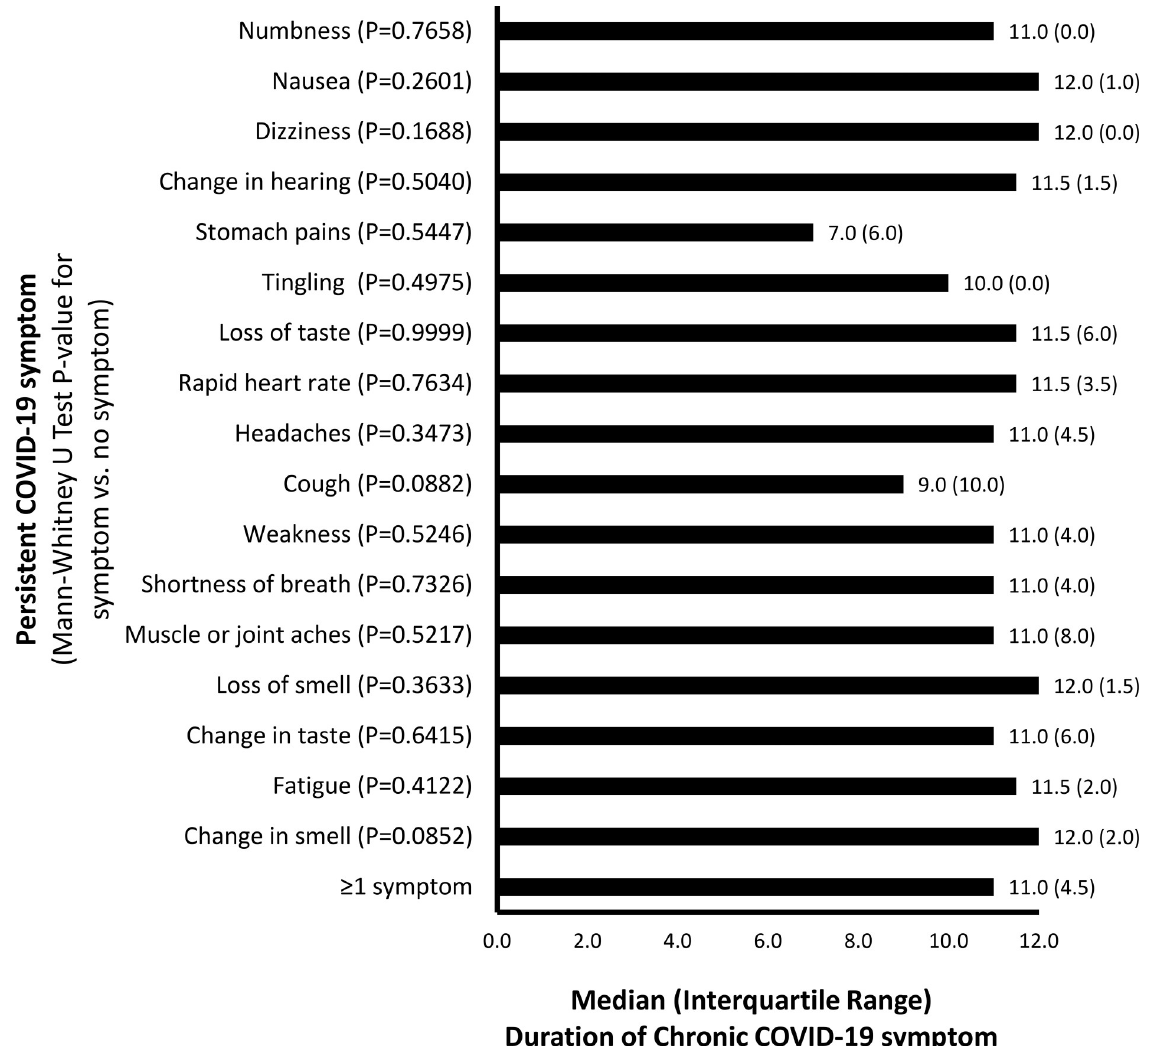
Fig 3. Duration of chronic COVID-19 symptoms. Median duration of chronic COVID-19 symptoms were determined overall and stratified by individual symptoms. Mann-Whitney U tests were performed comparing the duration of chronic COVID-19 symptoms between those with vs. without a history of acute COVID-19 symptoms. P-values are presented in the